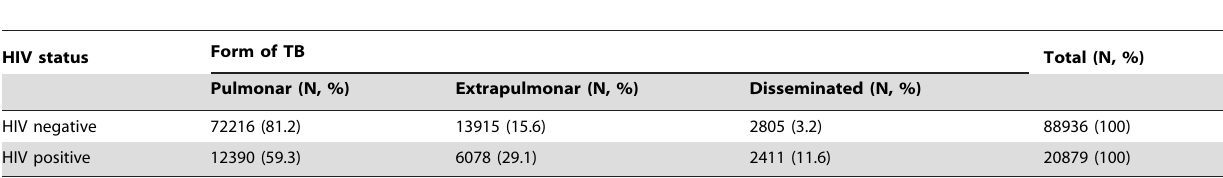
Table 3. Form of TB presentation by HIV status among new TB cases diagnosed in selected States of Brazil between 2003 and 2008 (n=